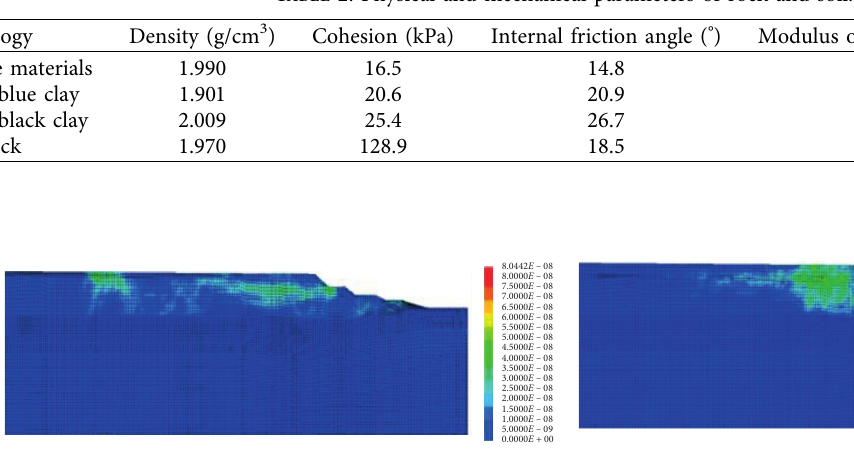
Table 2: Physical and mechanical parameters of rock and soil.